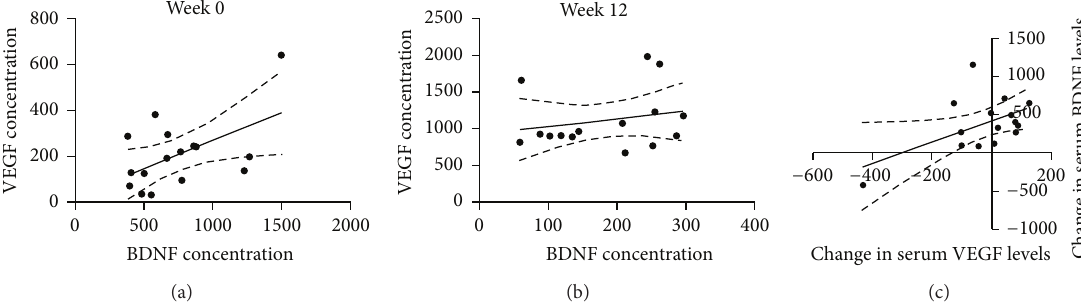
Figure 4: Relationship between BDNF and VEGF levels. Correlation analysis of serum BDNF and VEGF levels at separate time points reveals a significant relationship at week 0 (a) but not at week 12 (b). Further analysis found a significant correlation between the differences in BDNF and VEGF levels